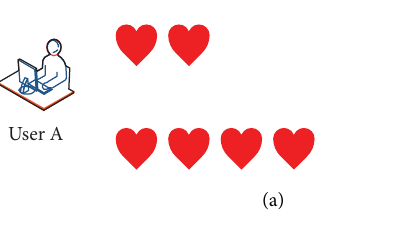
Figure 5: The score of items.